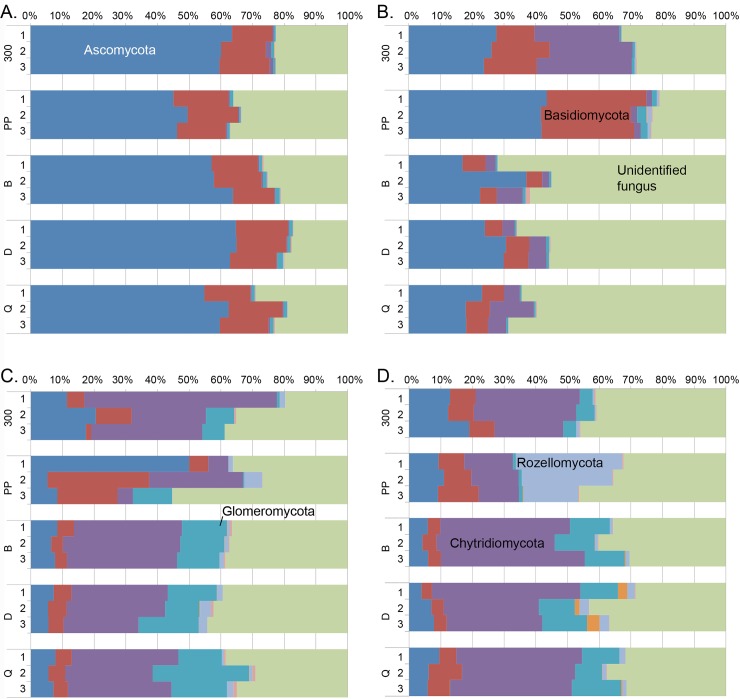
Relative abundance of fungal phyla.